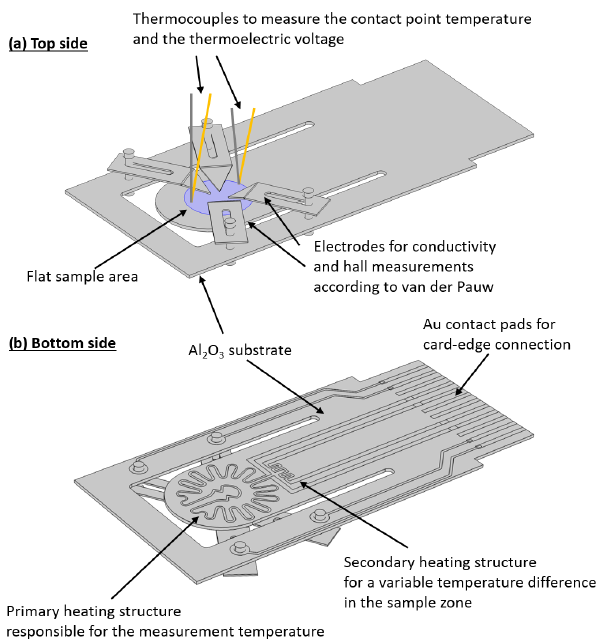
Figure 2. Sample holder concept: (a) top side of the Al 2 O 3 sample holder with a flat sample zone, four movable contacts for any sam- ple geometry according to the van der Pauw method, two additional thermocouples to measure the contact point temperature, and the thermovoltages to determine the Seebeck coefficient; and (b) bot- tom side of the sample holder with the primary heating structure that is responsible for the overall sample temperature and a sec- ondary heating structure for variable temperature differences in the sample zone to determine the Seebeck